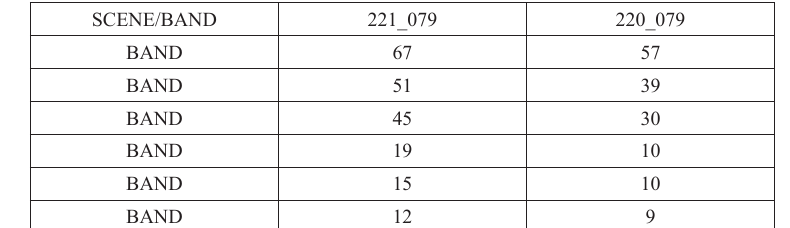
Value used to subtract the atmospheric influence in the LANDSAT ETM 7 + scenes, based on the “Simple Dark Pixel Subtraction” method (Chavez Jr 1975).